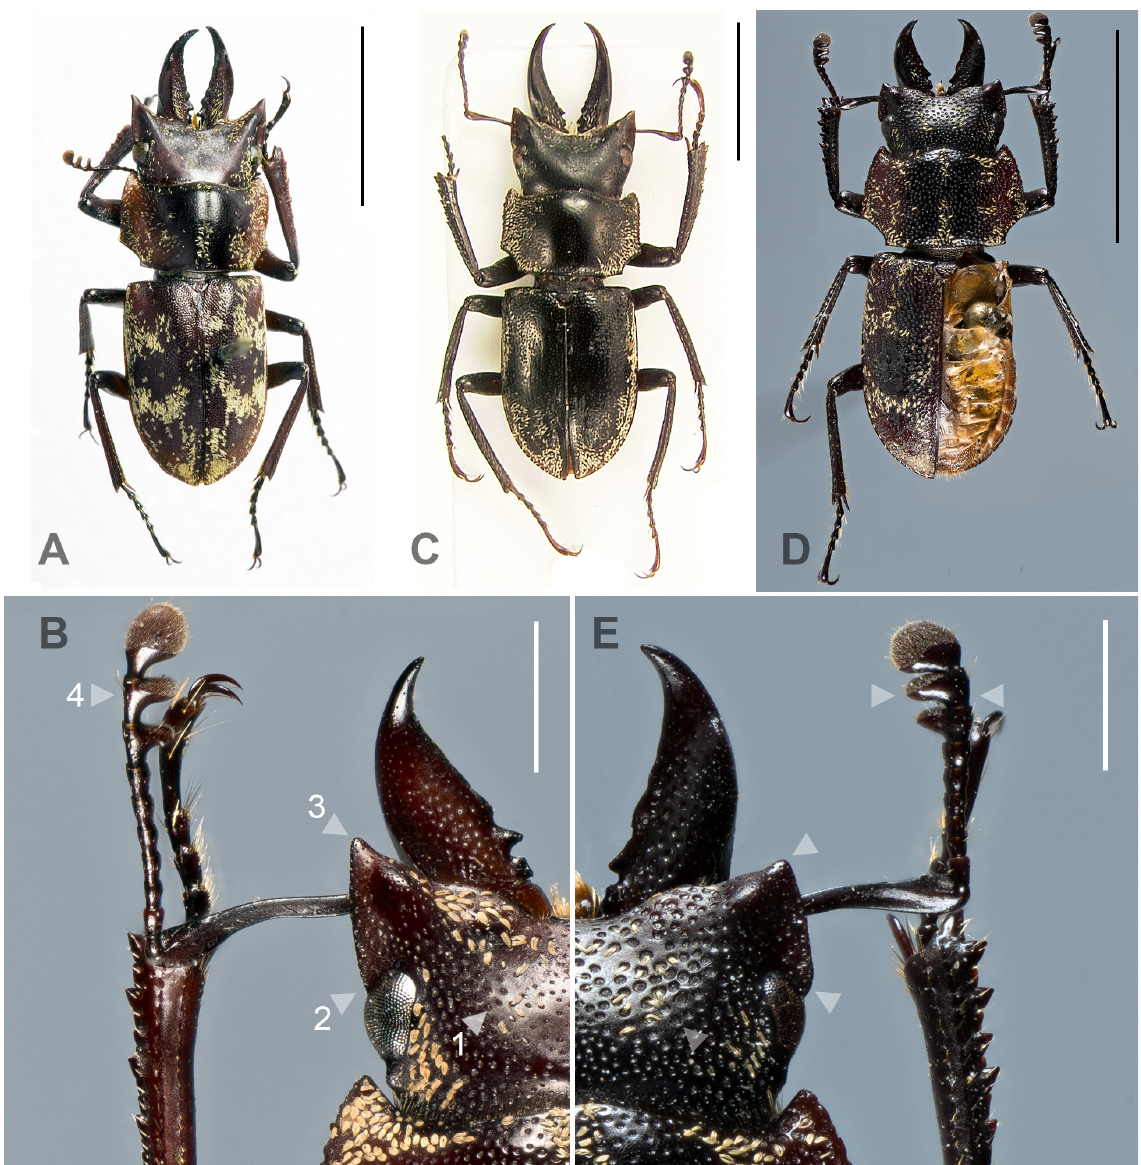
Fig. 2. A–B . Auxicerus platyceps Waterhouse, 1883. A . Holotype, ♂, BL 13 mm (BMNH). B . Head, ♂, BL 11 mm, Bolivia, Consata (EPCG). — C . Auxicerus aethiops Jakowleff, 1900, holotype, ♂, BL 16 mm, Bolivia (ZIRAS). — D–E . Auxicerus magnipunctatus sp. nov., holotype, ♂, BL 10.7 mm (CBF). D . Dorsal habitus. E . Head. Diagnostic characters indicated by arrows: (1) ocellate punctures on mesosternum, (2) posterior end of ocular canthus, (3) anterior edge of ocular canthus and (4) antennal lamellae. Scale bars: A, C–D = 5 mm; B, E = 2.5